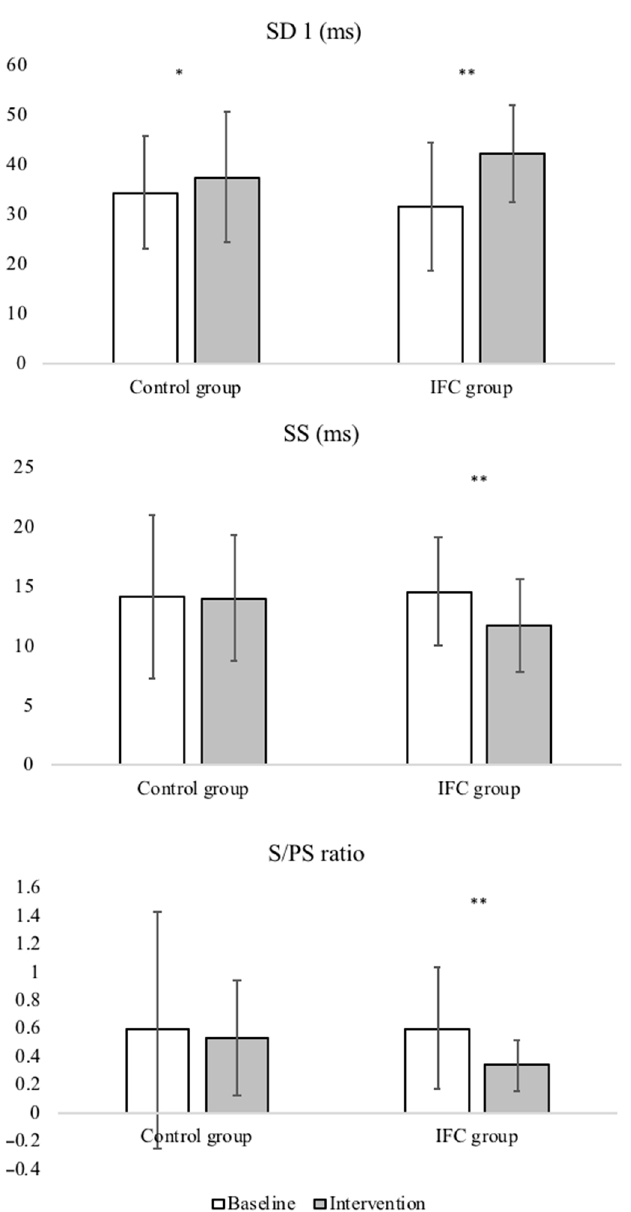
Figure 4. Comparison of SD1, SS, and S/PS ratio between baseline and during intervention for both groups. * Indicates statistically significant within-group differences ( p < 0.05); ** Indicates statistically significant within-group differences ( p < 0.001).